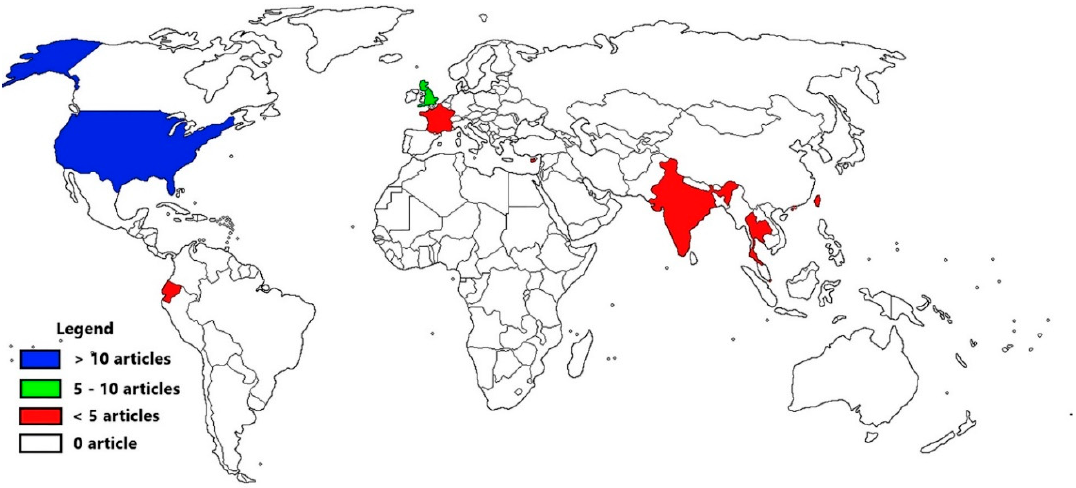
Figure 2. Map of the world showing the locations where studies have been conducted. Modified from Wikimedia Commons [62].